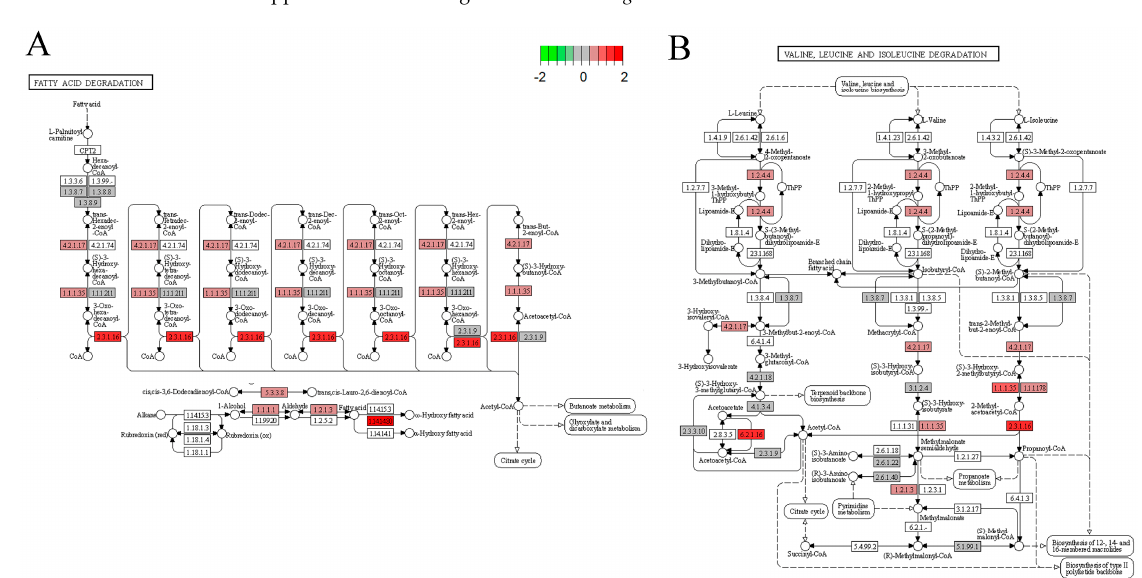
Figure 7. KEGG pathway analysis. ( A ) KEGG pathway map of fatty acid degradation signaling pathway; ( B ) KEGG pathway map of valine, leucine and isoleucine degradation signaling pathway. n = 4/group. LFD: low-fat-diet group; HFD: high-fat-diet group; HFD + EA: high-fat-diet supplemented with ellagic acid; HFD + EA + BC77: high-fat-diet supplemented with ellagic acid and W. coagulans BC77; HFD + EA + BC2000: high-fat-diet supplemented with ellagic acid and W. coagulans